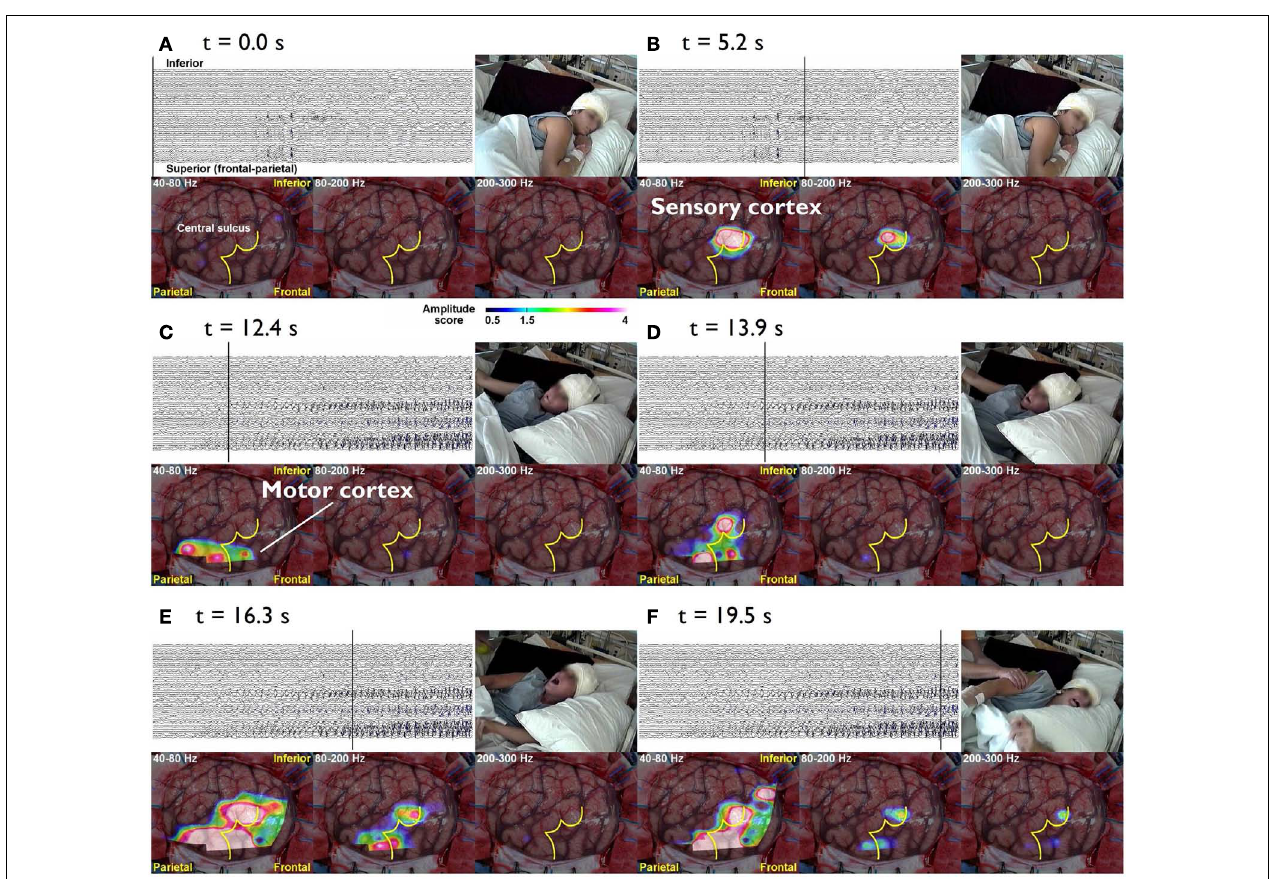
80–200Hz activities start building up in the EEG, they gradually spread anteriorly toward the motor cortex of the left hand and tonic flexion of the left arm is seen. (D) t = 23.6s Subsequently, the activities within all three bands (40–300Hz) gradually increase in amplitude and spread to adjacent areas. Activities at 40–80 and 80–200Hz also spread to the inferior rolandic region. However, even when the seizure becomes secondarily generalized, the HFOs are confined to the rolandic region ( E,F ) (Akiyama et al.,